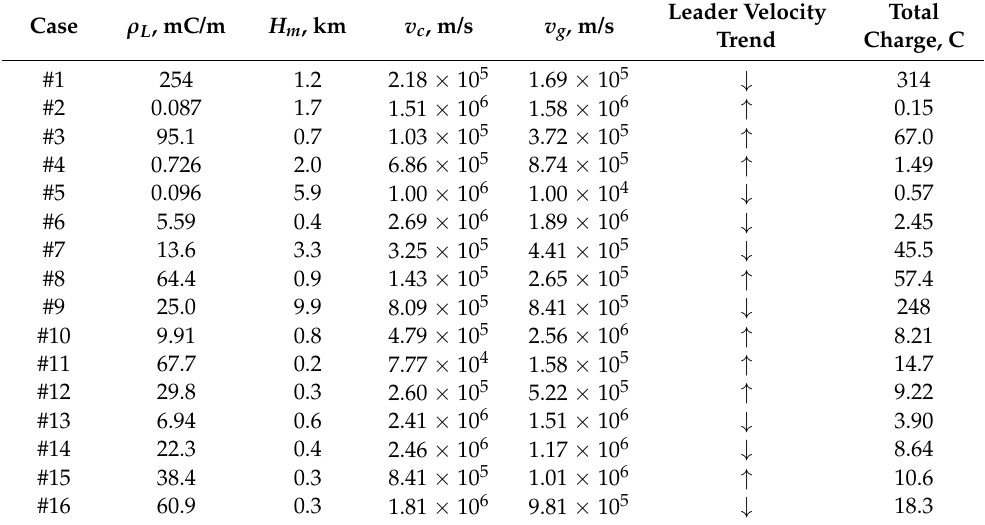
Table 3. Set of positive lightning leader parameters obtained from the used model fitting and auxiliary computations. “ ↑ ” stands for increasing trend and “ ↓ ” stands for decreasing trend,